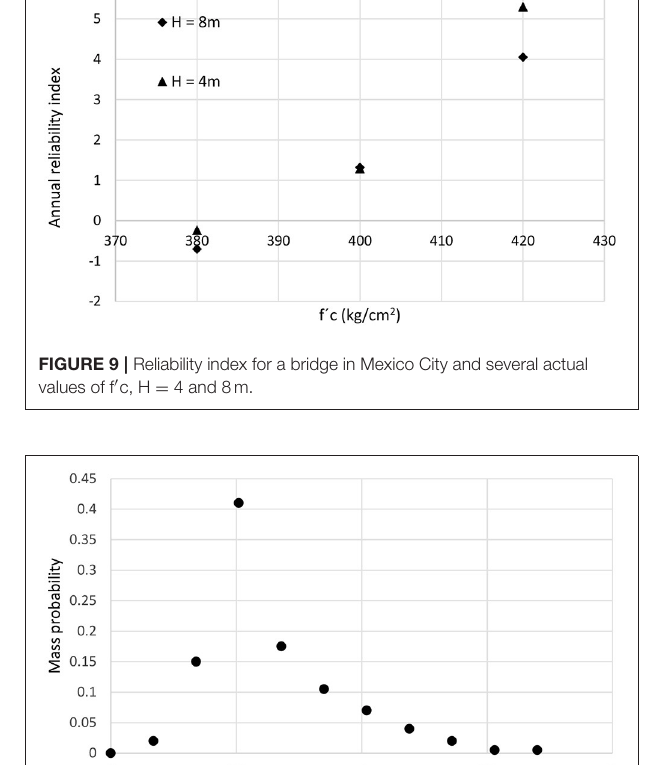
TABLE 5 | Initial costs for scenario seismic ground accelerations (million USD) for Acapulco and H = 4m, f ′ c = 420 kg/cm 2 .